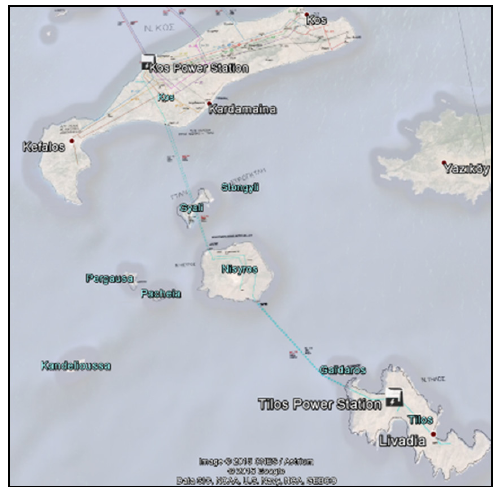
Figure 12. The R-44 Interconnector from Kos.